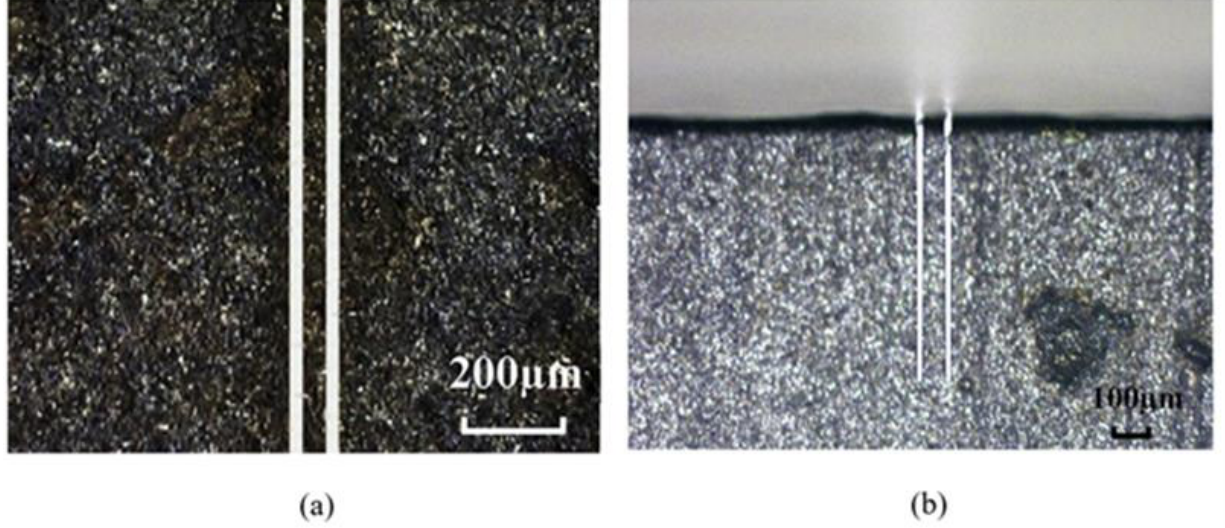
Figure 8. Fine grooving of cemented carbide (groove depth 1 mm, width 20 μm, and length 8 mm): ( a ) top view of deep grooves; ( b ) cross-sectional view of deep grooves. Adapted with permission from Ref. [39]. 2018, Elsevier.